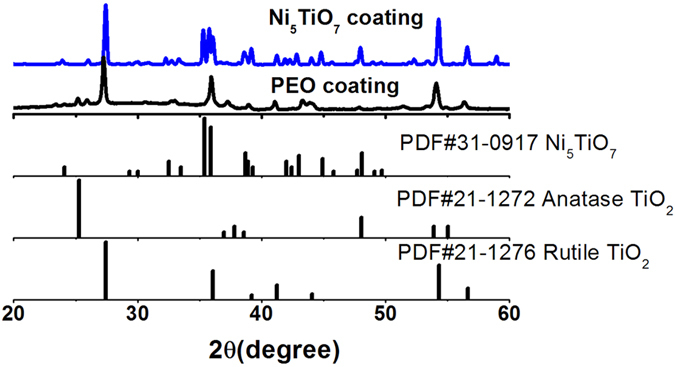
XRD patterns of PEO coating and Ni5TiO7 layer after annealing at 1050    °C for 1 hour; Standard XRD data of Ni5TiO7, anatase TiO2 and rutile TiO2 are also shown as references.